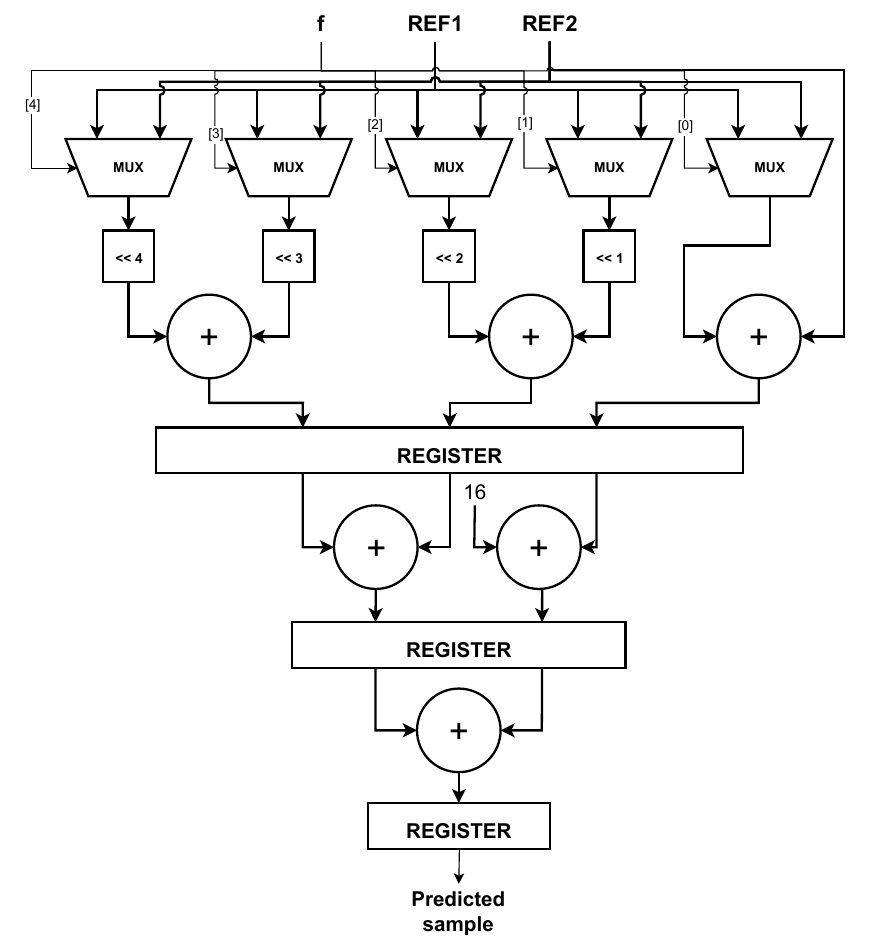
Figure 10. The structure of Processing Element for Angular (PEA)